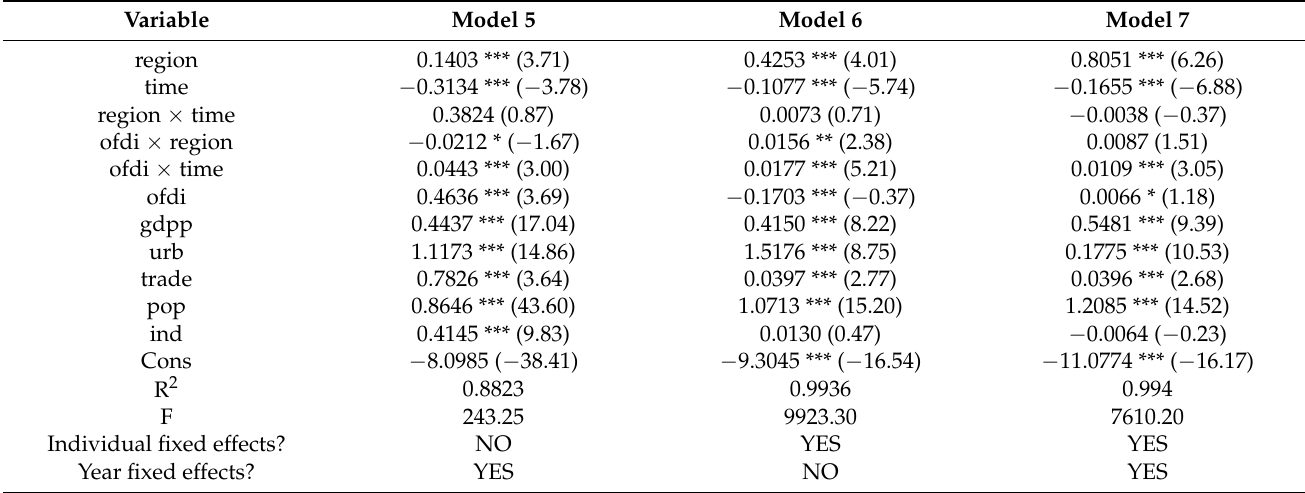
Table 7. The test for policy effects under fixed